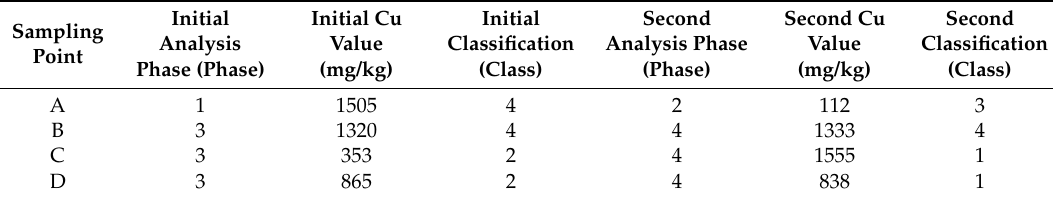
Table 3. Re-investigation results for sampling points suspected to be influenced by